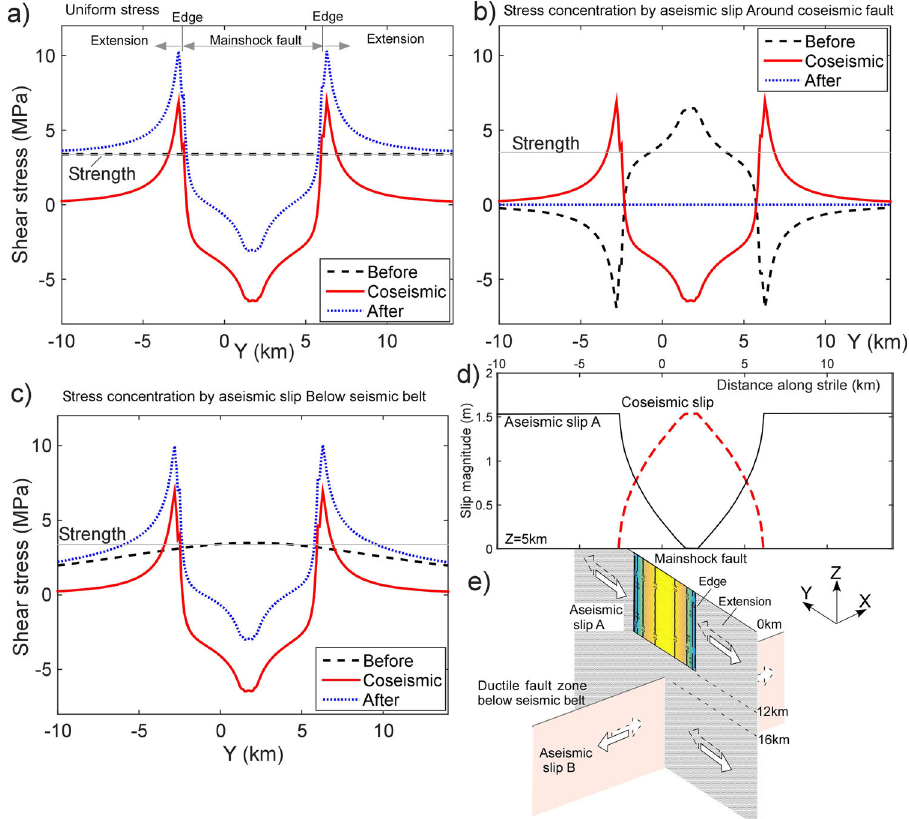
Fig. 1 Stress pro fi le along the fault strike for a vertical strike-slip fault. a Uniform stress case. The shear stress on the mainshock fault, at the edge, and in the extension before and after the mainshock shown by the black dashed, and blue dotted lines, respectively. The coseismic change is shown by a red line. The apparent strength of the fault is shown by a grey line. b Case of stress concentration by the aseismic slip around the mainshock fault. The aseismic slip (A) mainly occurred on the fault shown by grey in Fig. 1e. c Case of stress concentration by the aseismic slip below the seismic belt 38 . The aseismic slip (B) occurred in the ductile fault zone below the seismic belt shown by pink in Fig. 1e. d Slip pro fi les of the coseismic slip and the aseismic slip around the mainshock fault for the case ( b ) . e Geometries of the mainshock fault and the surrounding aseismic fault, and the ductile fault below the seismic belt. The slip distribution of the mainshock fault is shown by colour